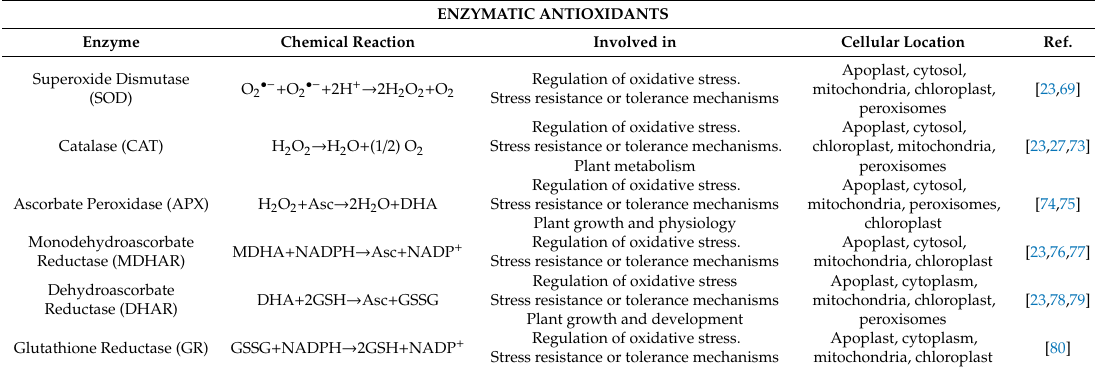
Table 1. Schematic overview of the enzymatic antioxidants.